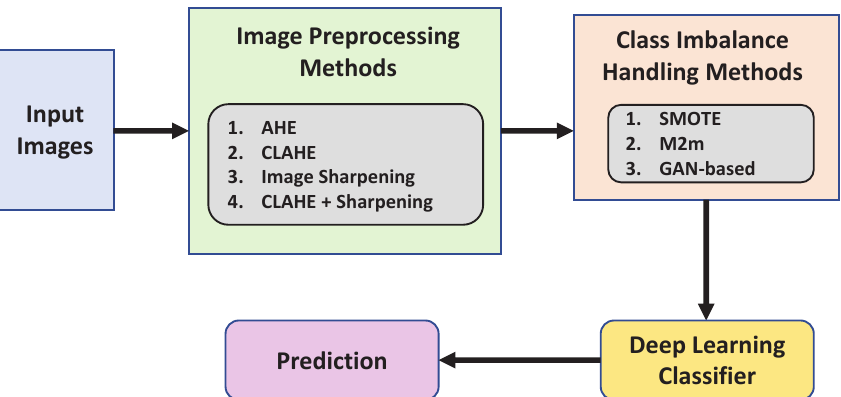
Figure 1. The workflow of a plant disease detection system. First, image preprocessing techniques improve the images, and then class imbalance techniques address the inequalities of the minority class. A deep learning classifier provides the prediction. Here, we also list the various techniques we consider for this study for each